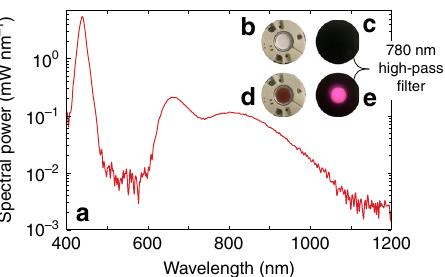
Fig. 7 Broadband near-IR LED. a Spectral output of the constructed broadband infrared (IR) light-emitting diode (LED). The inset shows the LED design, comprising a blue pumping LED ( b ), combined with the CaS:Eu, Tb broadband infrared phosphor ( d ), under operation below a 780-nm high-pass cut-off fi lter without ( c ) and with ( e ) the infrared phosphor present, captured by a camera with a near-IR